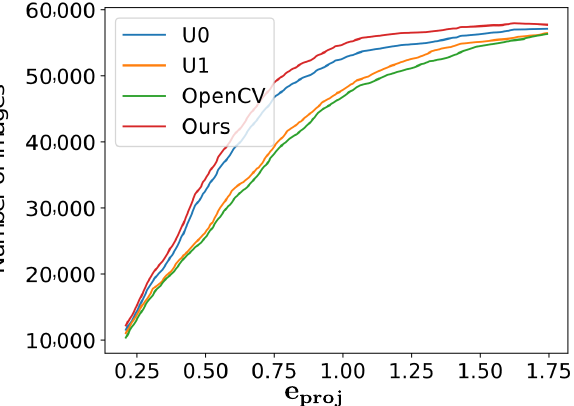
Figure 10. The value on the vertical axis indicates the accumulated number of images whose average projection errors were smaller than e proj . A larger number indicates a better